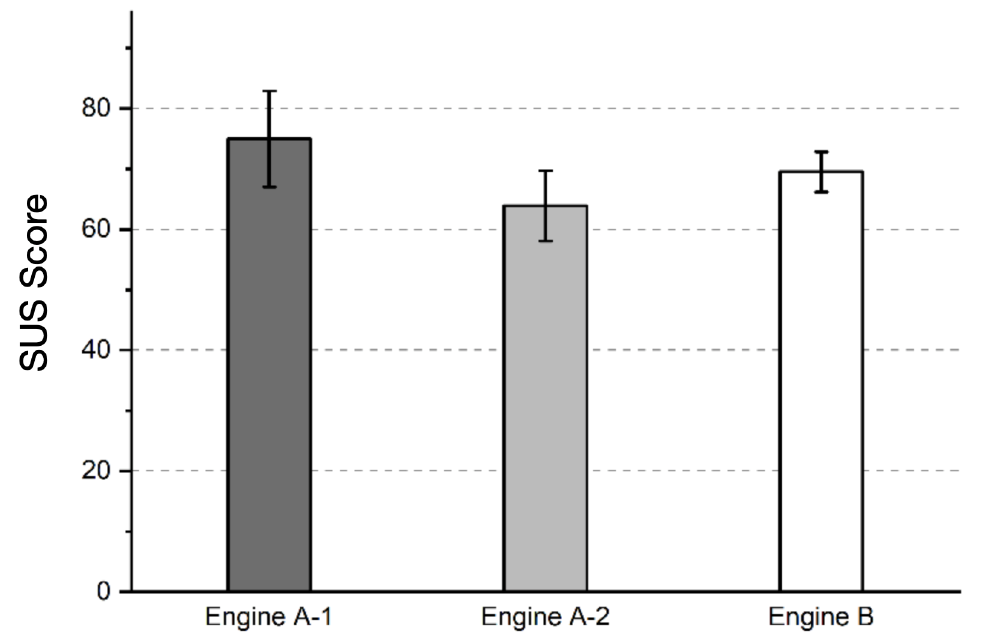
Figure 42. Mean SUS score for each participant in engine maintenance